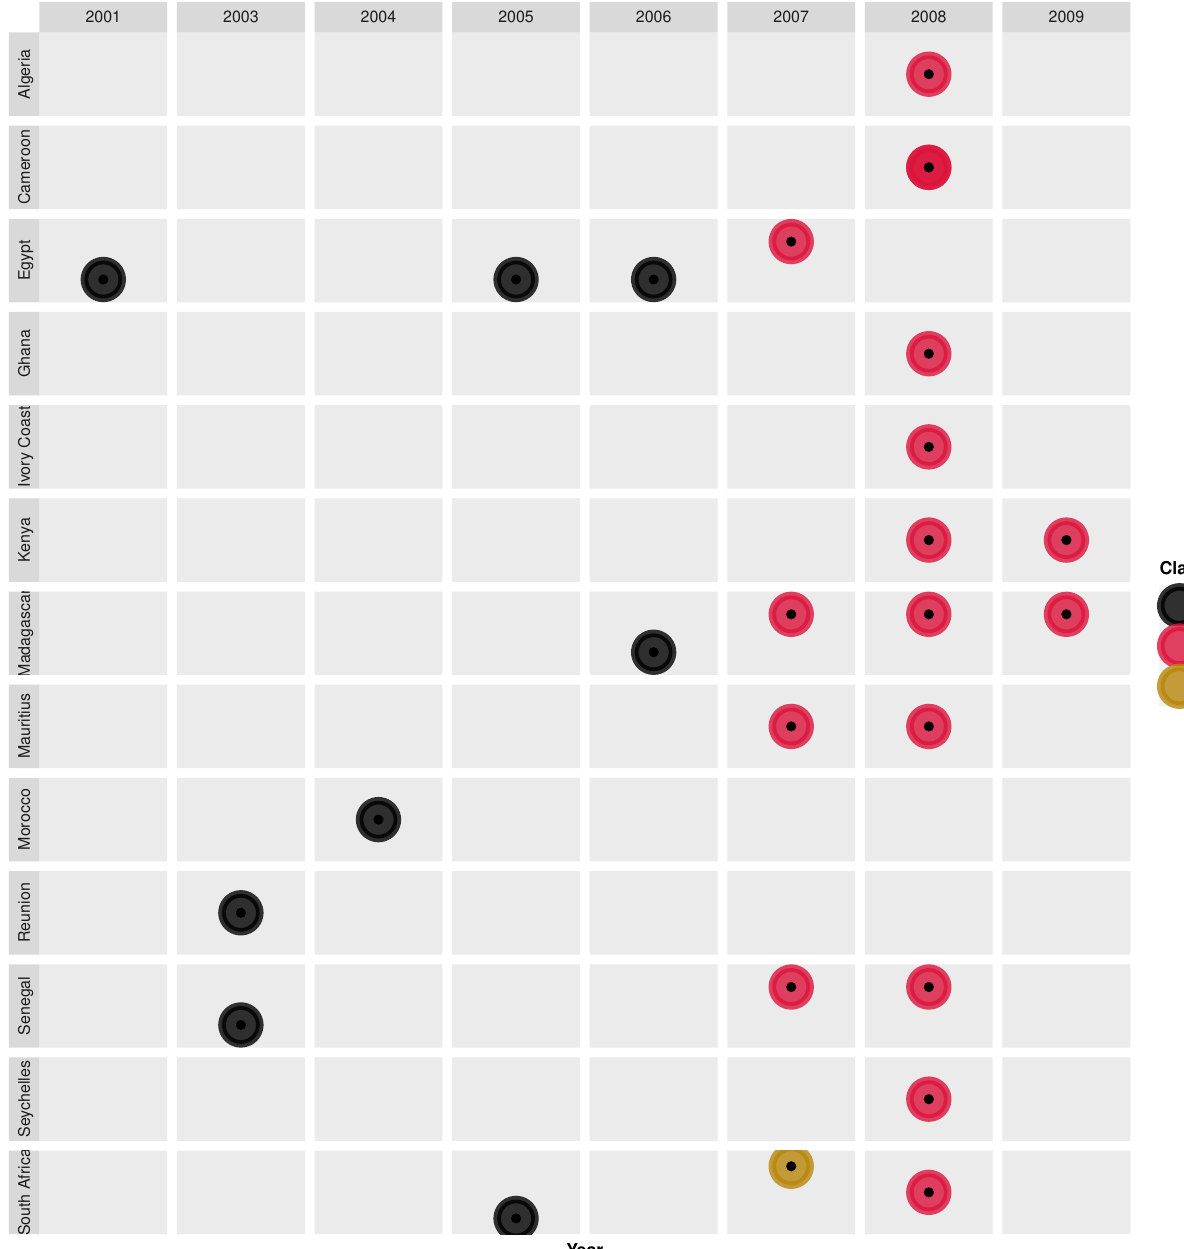
Figure 3. Temporal and geographical distribution of genetic clades of seasonal H1N1 virus strains that circulated in Africa between 2001 and 2009. Details on the characteristic genomic markers (amino acid substitutions in the HA1 proteins) for each clade are described in Table S8. A South Africa strain, A/Johannesburg/141/2007(H1N1), sampled in 2007, shared a similar H1 gene as an American-origin A/St.Petersburg/10/2007-like(clade 2C) strain with HA1 substitutions T82K, Y94H, and K141E [89]. In the same year (2007), new Australian- origin A/Brisbane/59/2007(H1N1)-like strains (clade 2B, mostly oseltamivir-resistant) with HA1 substitutions (D35N, R159K, E274K) emerged in Egypt, Madagascar, Mauritius, and Senegal [41,89]. Clade 2B was widely spread in 2008 in Northern (Algeria), Central (Cameroon), Eastern (Madagascar, Mauritius, Seychelles, Kenya), Western (Ivory Coast, Ghana, Senegal), and Southern Africa (South Africa), clustering according to